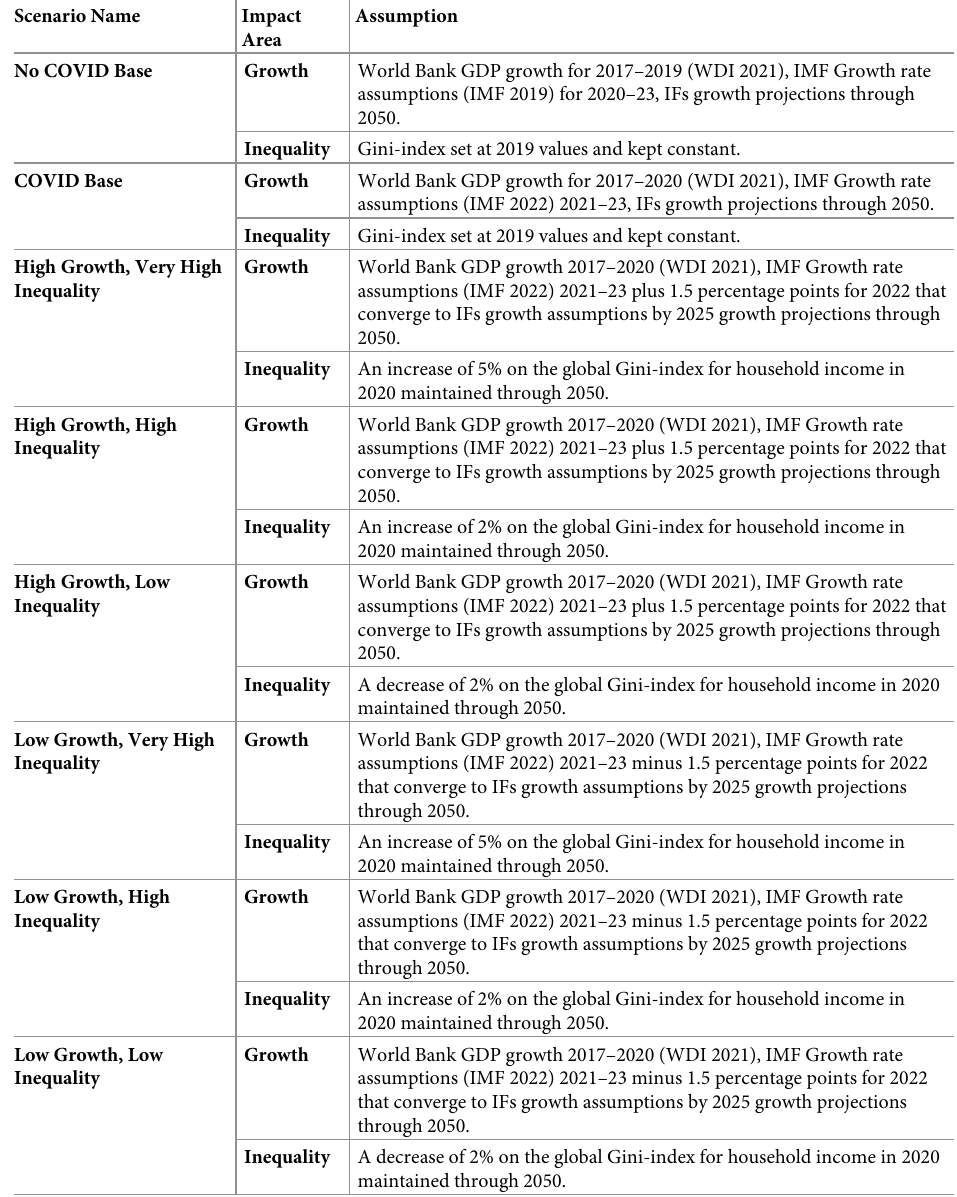
Table 1. Scenarios